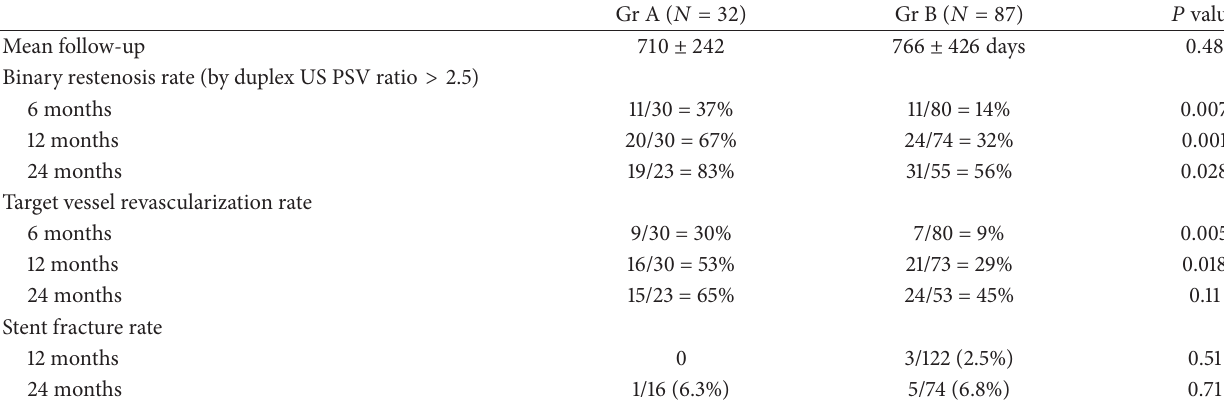
Table 5: Follow-up